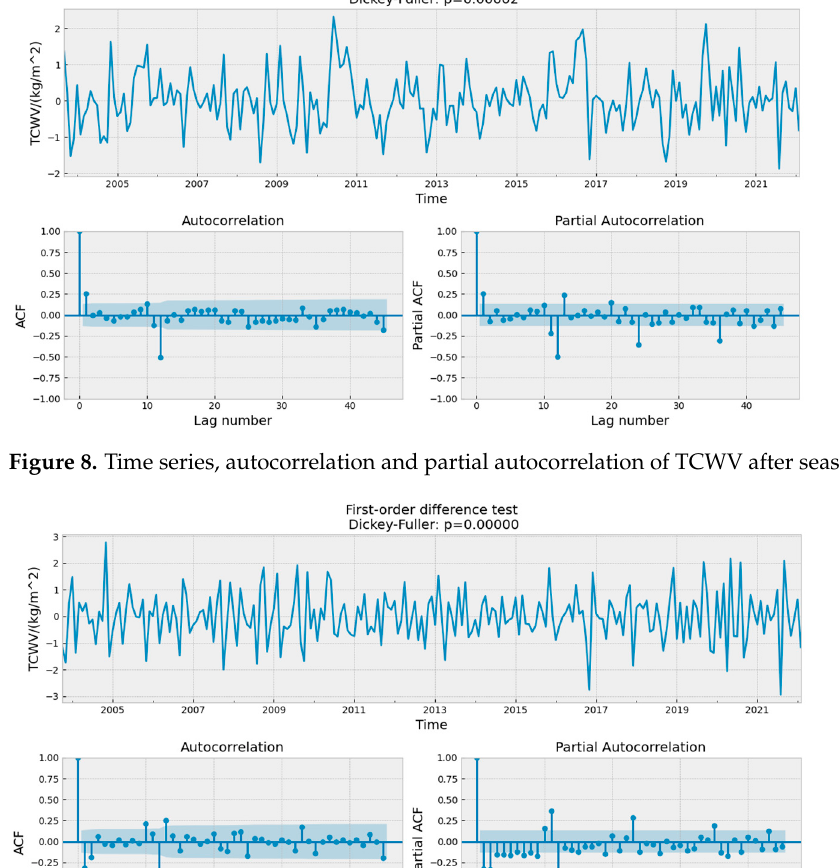
Figure 8. Time series, autocorrelation and partial autocorrelation of TCWV after seasonal difference.